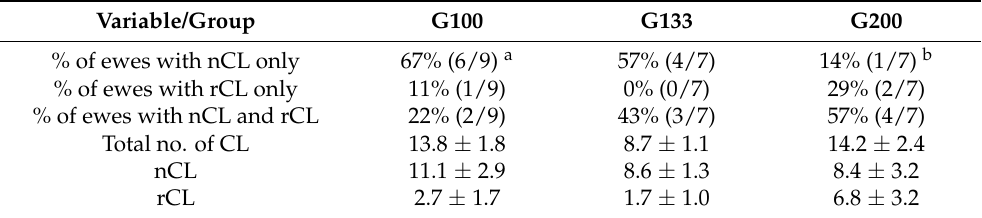
Table 1. Proportions (%) of animals with different types of corpora lutea [CL; normal (nCL) or regressing (rCL)] and mean ( ± SEM) numbers of luteal structures determined laparoscopically on Day 15 of the superovulatory protocol in Santa In ê s ewes superovulated with 100 (G100), 133 (G133), or 200 (G200) mg of pFSH administered in eight decreasing doses. Variable/Group G100 G133 G200 % of ewes with nCL only 67% (6/9) a 57% (4/7) 14% (1/7) b % of ewes with rCL only 11% (1/9) 0% (0/7) 29% (2/7) % of ewes with nCL and rCL 22% (2/9) 43% (3/7) 57% (4/7) Total no. of CL 13.8 ±